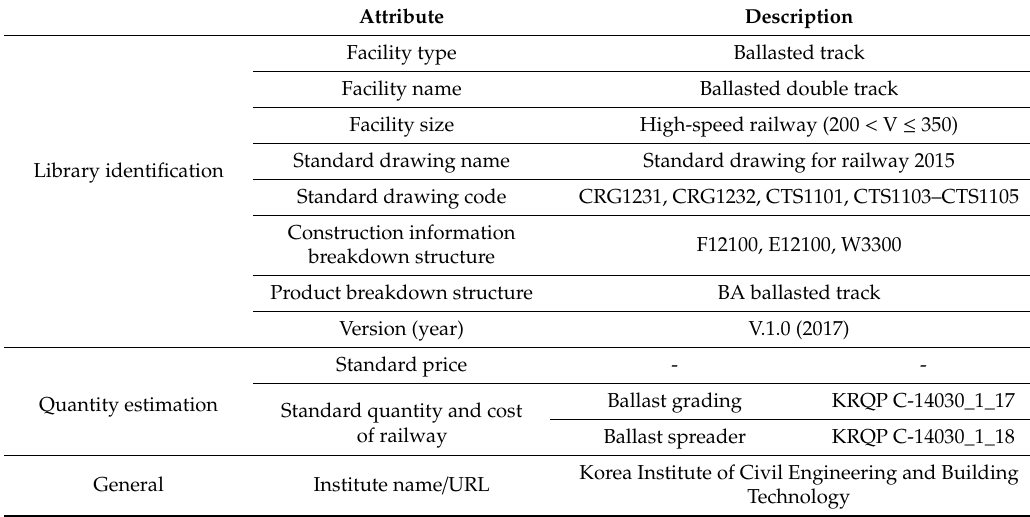
Table 4. Example of library attribute (ballasted track).